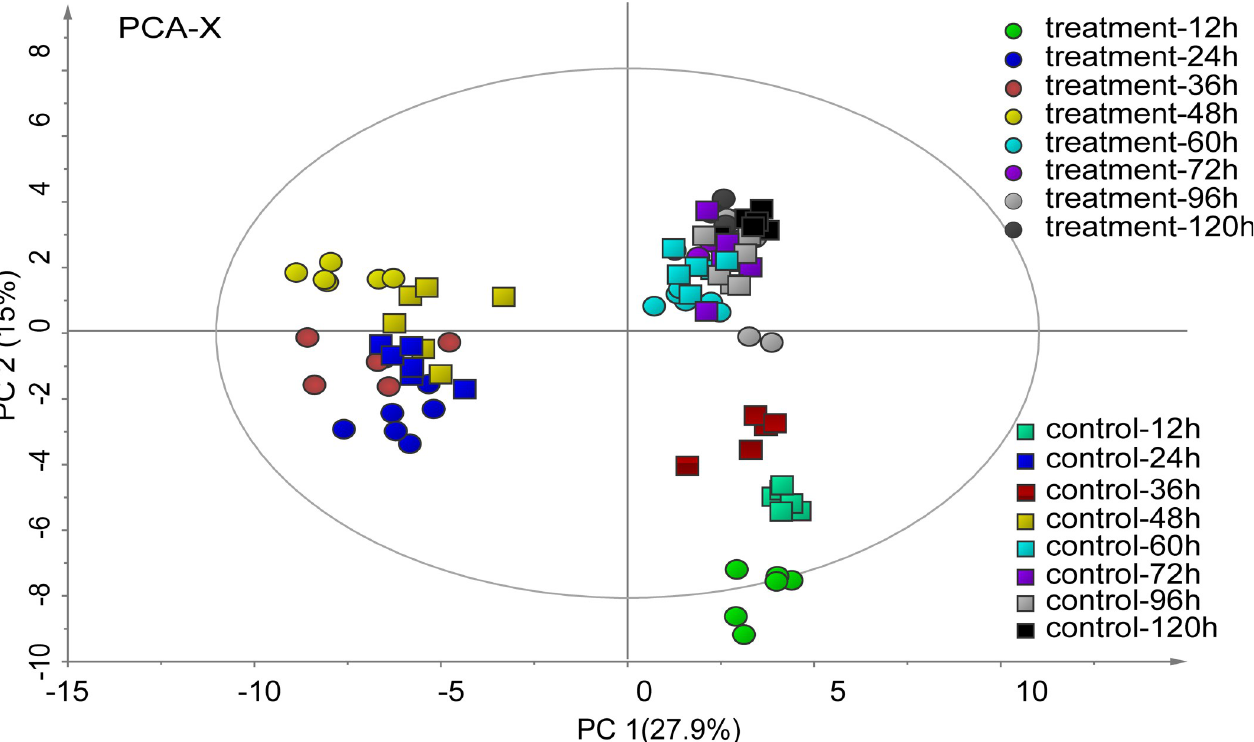
Fig 2. PCA of U . prolifera during its fragmentation-induced proliferation. The green, dark-blue, brown, pale-yellow, pale-blue, purple, gray and black colors represent treatment the 12, 24, 36, 48, 60, 72, 96, and 120 h treatments respectively, and boxes ( □ ) and circles ( � ) represents the control and treatment groups, respectively; n =